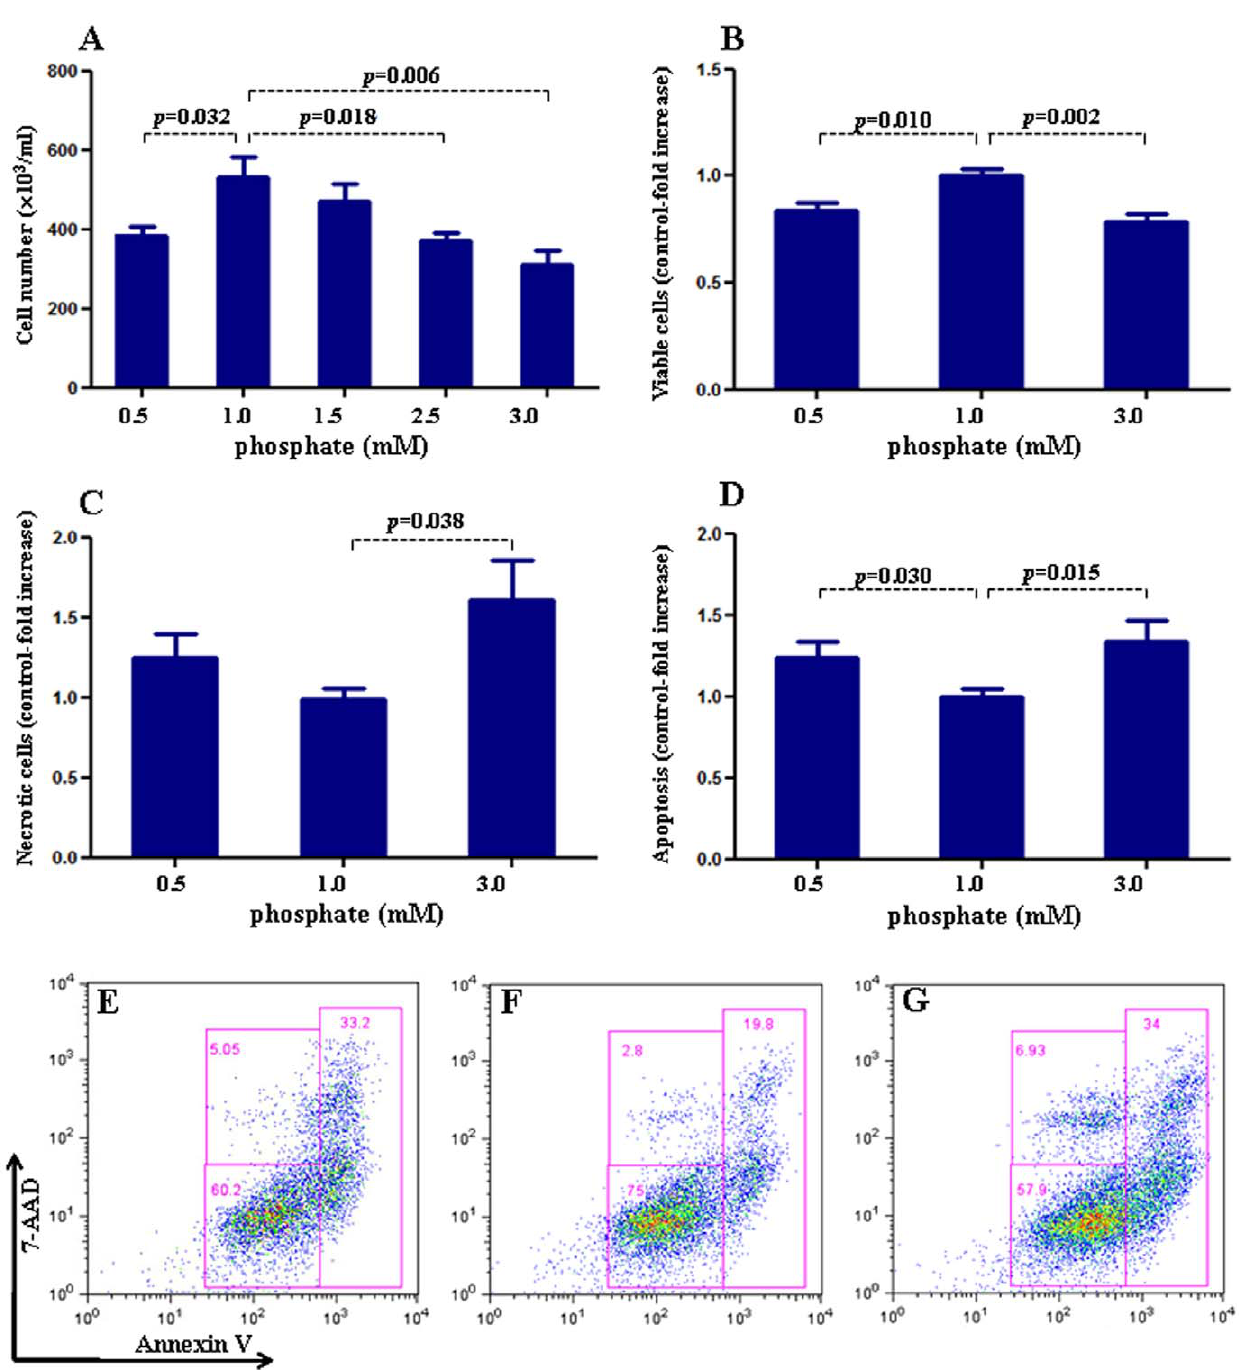
Figure 1. Effect of inorganic phosphate on endothelial cell proliferation and apoptosis. We examined the effect of exposure to different concentrations of inorganic phosphate for 24 hours on human umbilical vein endothelial cell proliferation and apoptosis. In Figure 1A, cell number is determined by light microscopy counting of trypan blue-excluding cells, whereas B–D pertain to flow analysis. Incubation in media simulating hypophosphatemia (0.5 mM) or hyperphosphatemia (3 mM phosphate) resulted in a significant reduction of cell numbers (A), decreased cell viability (B) and increased cell dearth (C, statistically significant only seen in hyperphosphatemia) when compared to cells incubated in the medium containing 1 mM phosphate. Similarly, incubation in media simulating hypophosphatemia (0.5 mM, D & E) or hyperphosphatemia (3 mM phosphate, D & G) resulted in a significant increase in apoptotic cells when compared to cells incubated in the medium containing 1 mM phosphate (D & F). In Figure E–G, data in each quadrant are the percentage of total cells, and shown as mean + / 2 SEM. p values vs control (1 mM phosphate). N=6 ,